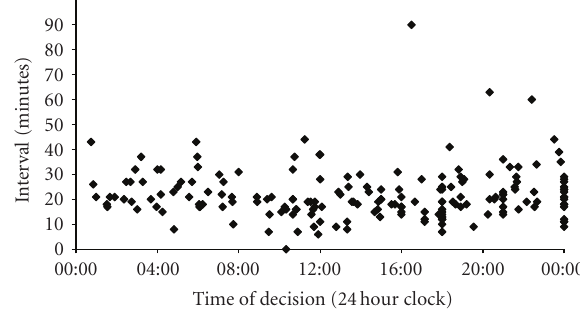
Figure 1: Decision-to-delivery interval versus time of day (grade 1).